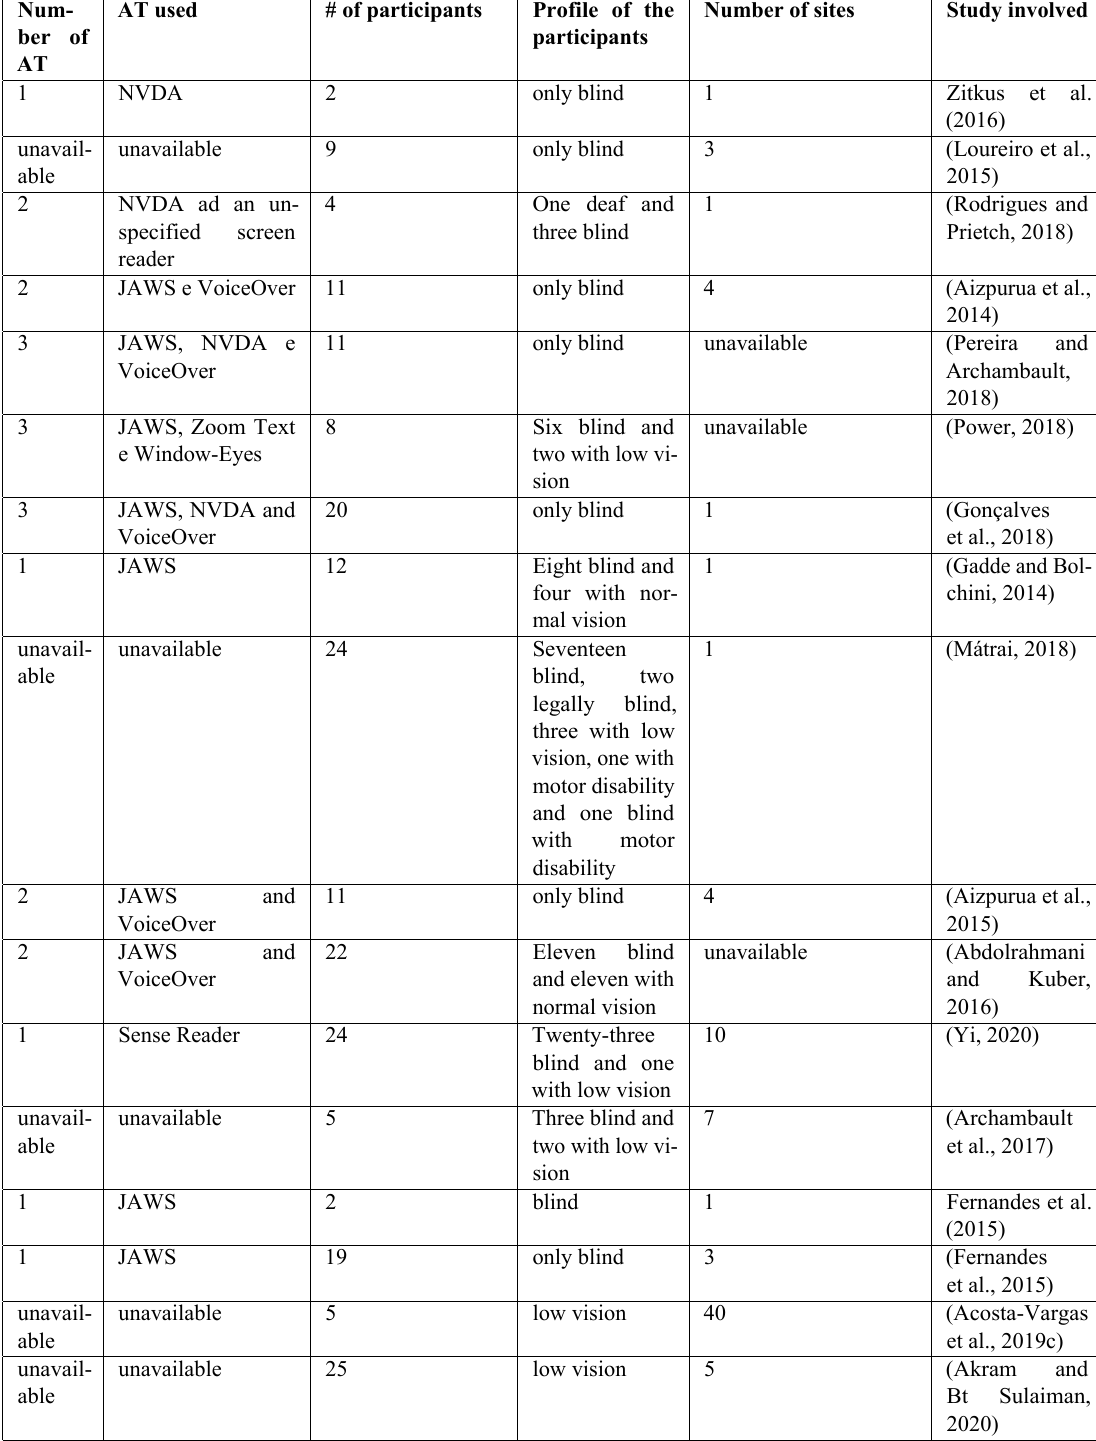
Table 6. Characteristics of user evaluations on